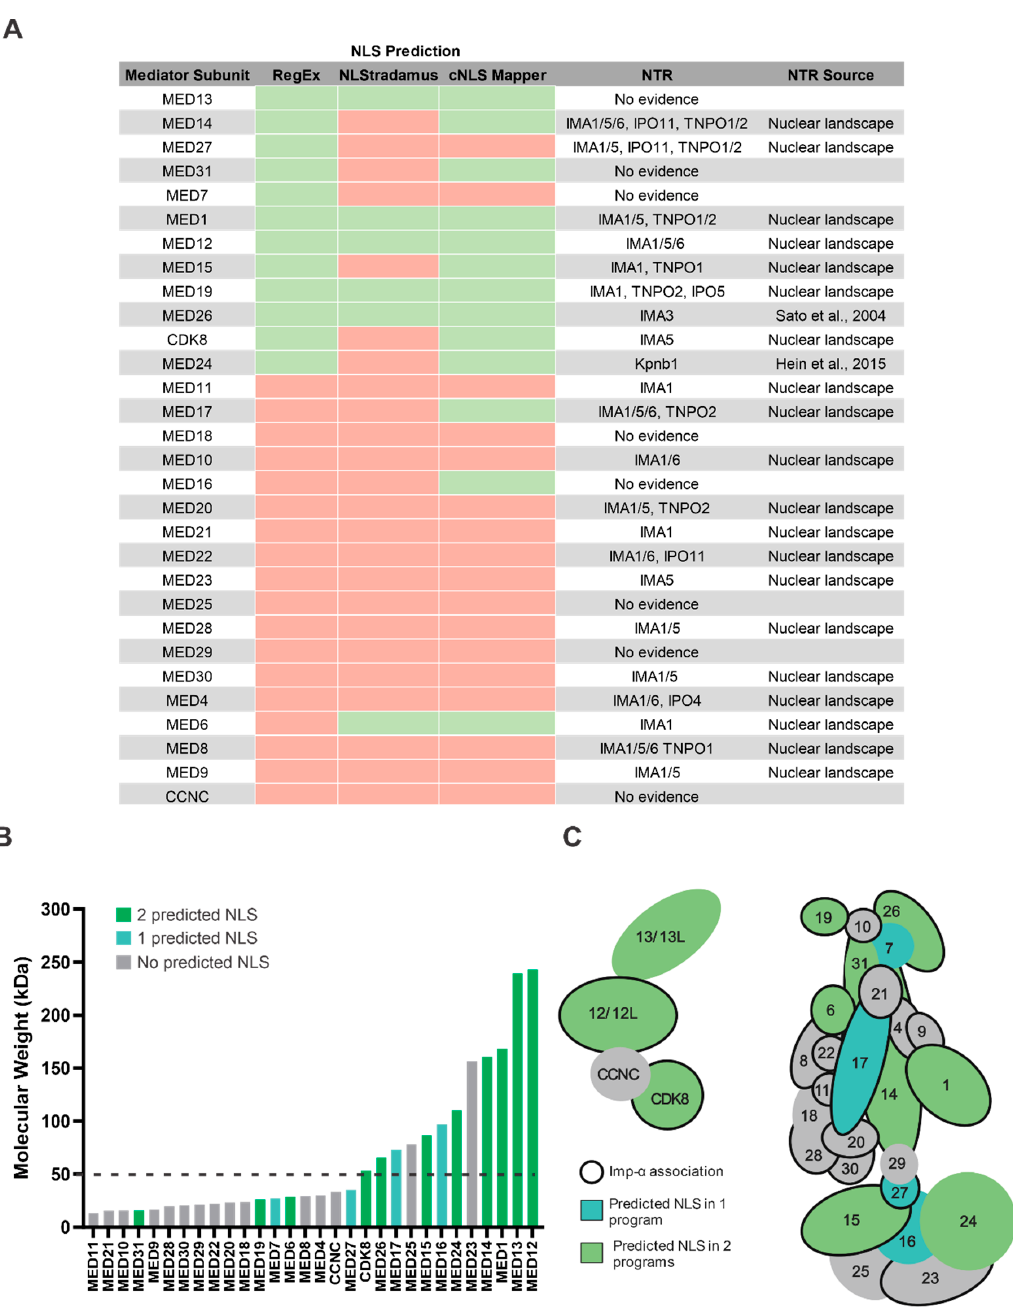
Figure 4. Mediator complex subunits may utilize a piggybacking mechanism for nuclear import. ( A ) Mediator subunits were analyzed for cNLSs using different cNLS prediction programs, and data was tabularized using Microsoft Excel. Many subunits have a predicted cNLS (green) from more than one program, while the majority do not have a predicted cNLS (red). Data from the Nuclear Landscape dataset and other published nuclear transport receptor (NTR) interactions show that many subunits associate with Imp- α , as well as transportin (TNPO). ( B ) Mediator subunits vary in molecular weight, with larger subunits more frequently having a predicted cNLS. Subunits with a cNLS predicted from two programs or more are shaded in dark green (2 NLS) and those with a prediction from only one program are shaded in light blue (1 NLS). Although imprecise, a passive diffusion limit of 50kDa (dotted line) shows that many subunits without a cNLS are below this cut-off. ( C ) A model figure of Mediator was adapted from Soutourina, 2018, to show corresponding subunits with predicted cNLSs as well as Imp- α associations.